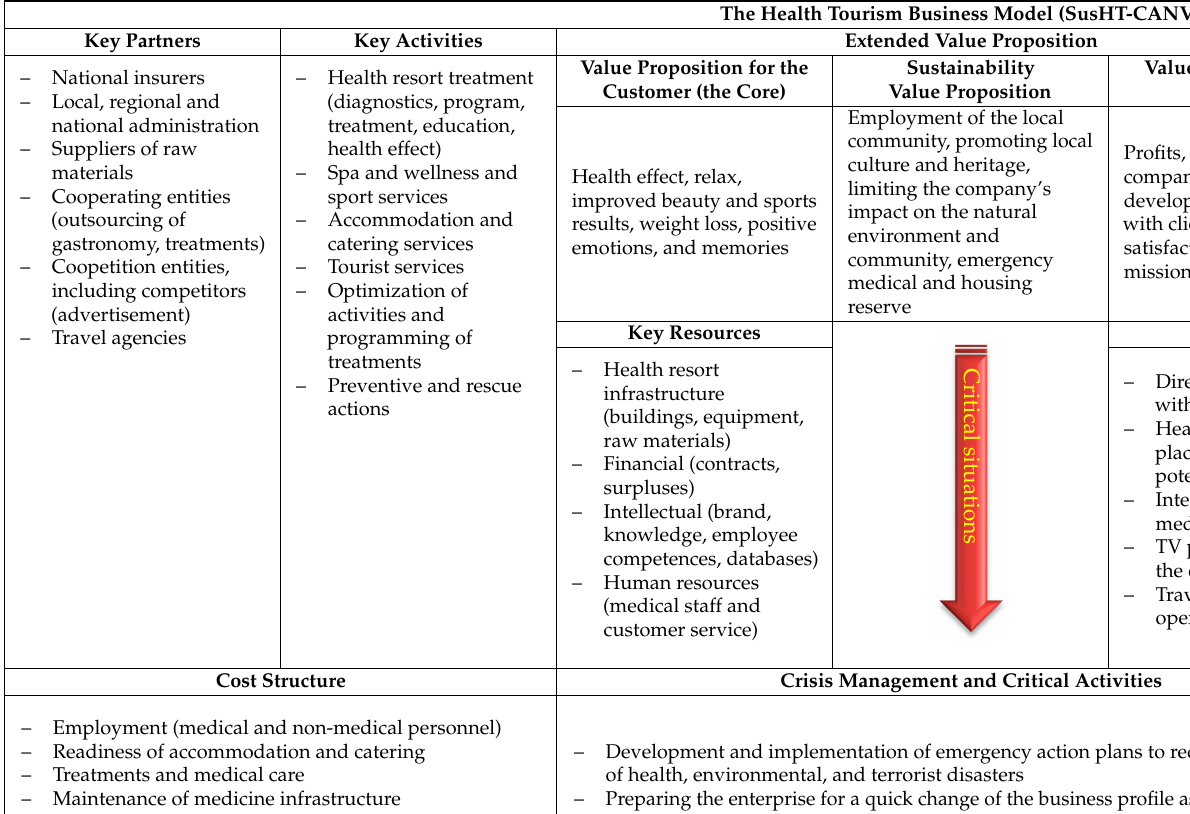
Table 5. Scheme of business model, SusHT-CANVAS. Sources: Own